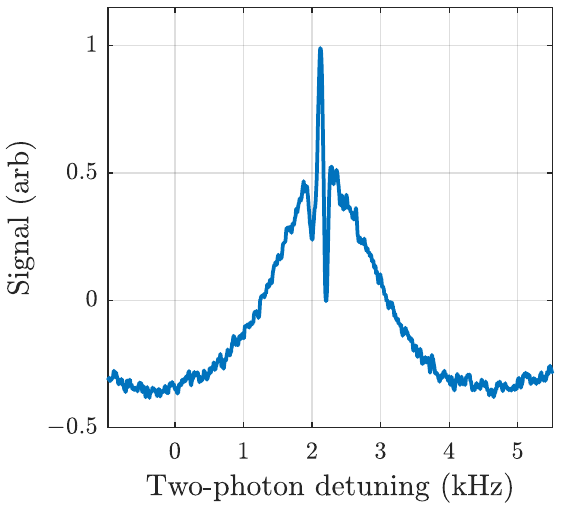
Figure 13. Experimentally measured Doppler-free Ramsey interference